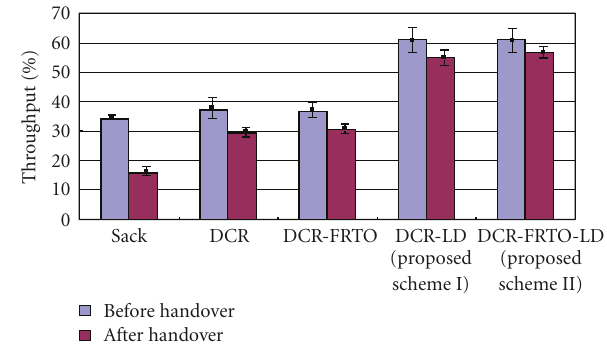
Figure 12: Handover from WLAN to cellular network.